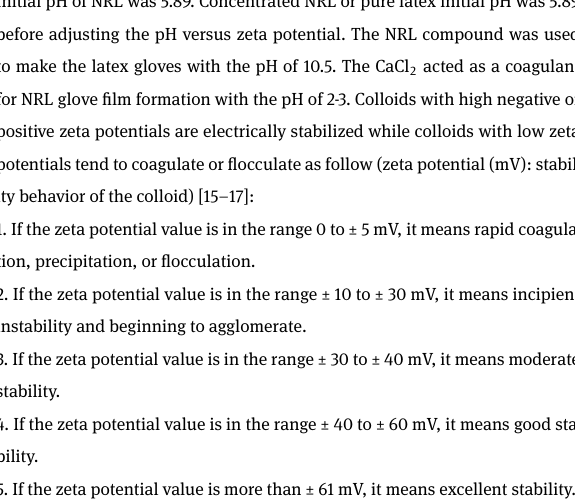
Figure 4: Comparison of zeta potential natural rubber latex on commercial, porcelain and bone china hand molds after firing at